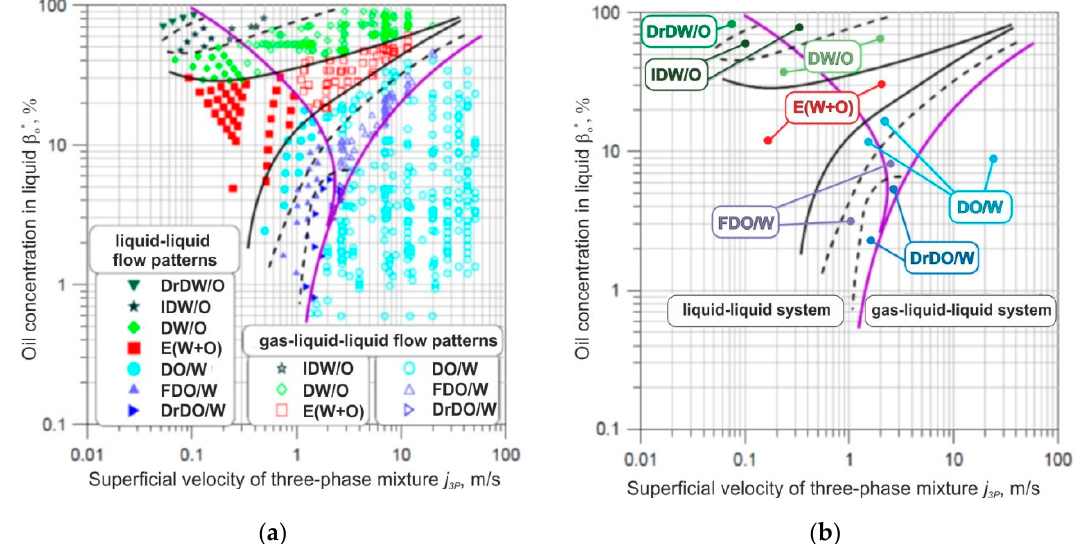
Figure 3. Gas–liquid–liquid three-phase flow map for annular falling flow. Map including data related to liquid–liquid two-phase flow, combined with ( a ) distribution of experimental points, ( b ) areas corresponding to the occurrence of specific flow patterns.